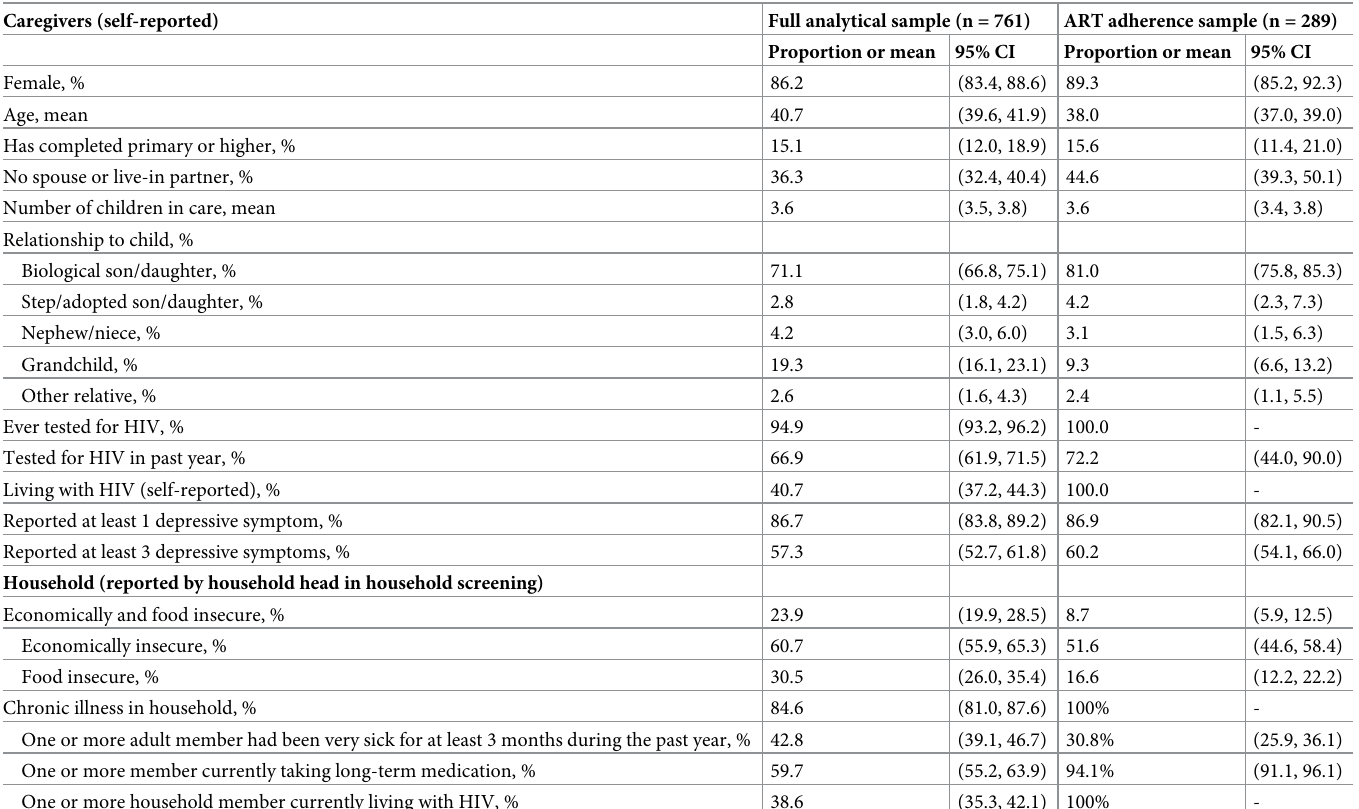
Table 1. Caregiver and household characteristics.